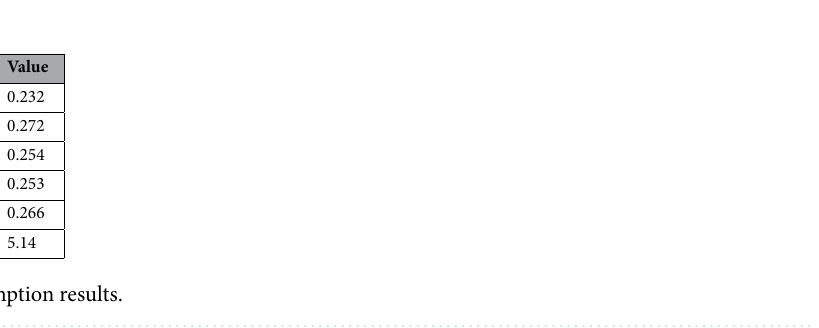
Figure 8. Lubricating oil consumption paths of ( a ) evaporation from liner wall, ( b ) oil throw off, ( c ) oil blow through top ring end gap, ( d ) oil scrapping of the top land.